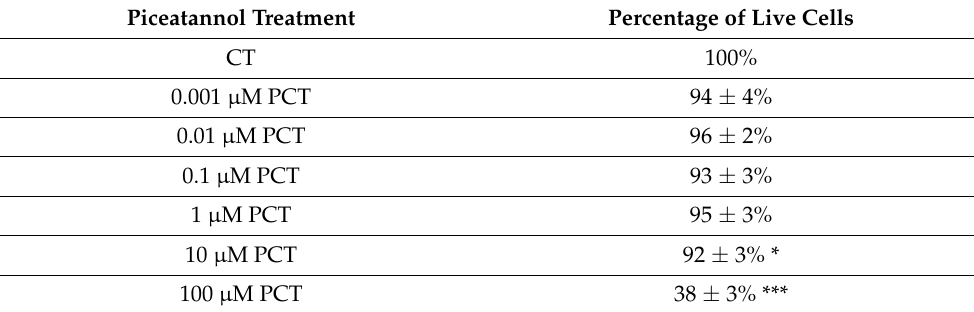
Table 1. Cytotoxicity assay. Piceatannol Treatment Percentage of Live Cells